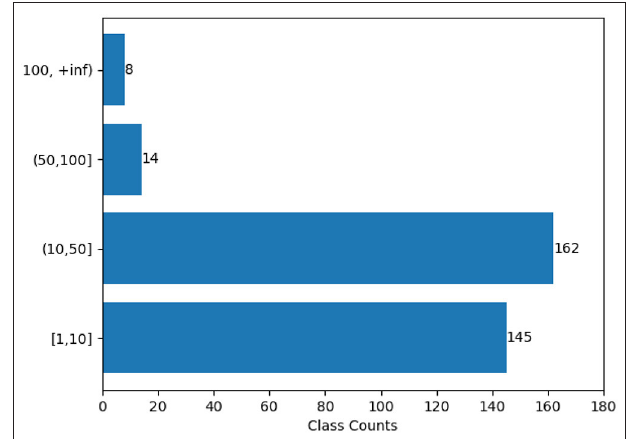
FIGURE 5 | Distribution of VerbNet classes based on their verb member count.